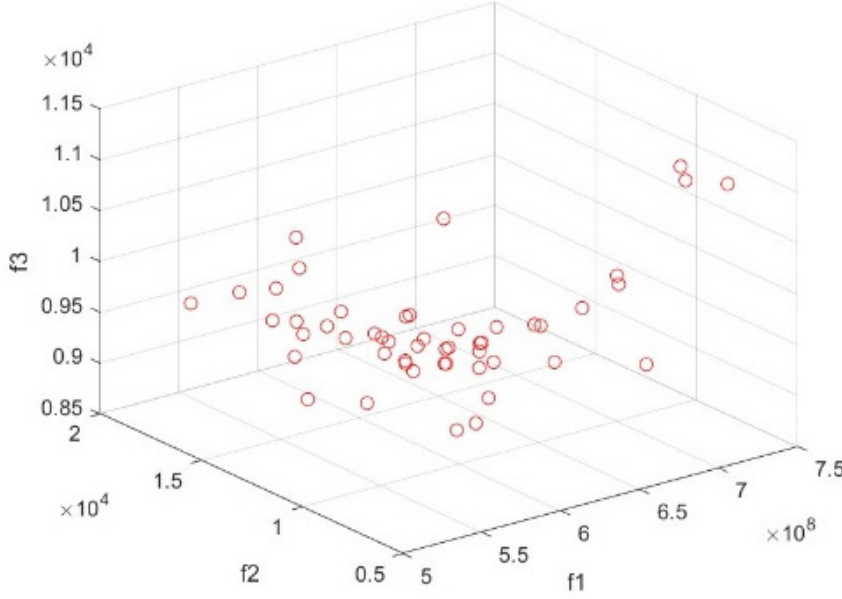
Figure 9. The Pareto Front chart of sample 8 by NSGA-II algorithm. Figure 10 also demonstrates the convergence process of each objective function.